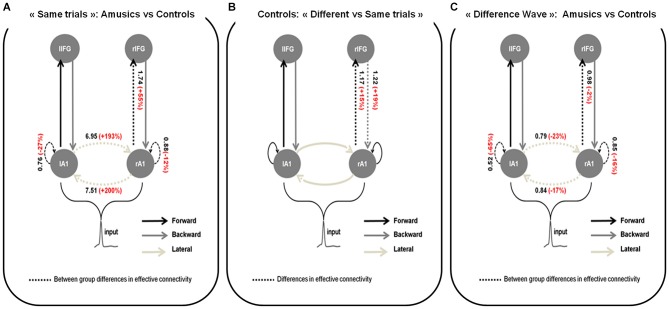
Wining models for (A) Amusics vs. Controls comparison for “Same” trials; (B) “Different” vs. “Same” trials in S2 for controls and; (C) Amusics vs. Controls for the “Difference Wave”. Dashed arrows indicate modulated connections (i.e., connections that differ between groups (A,C) or type of trial (B)) and solid arrows indicate fixed connections. Significant changes in effective coupling are specified (in black: amount of coupling change between groups (A,C) or type of trials (B); in red: corresponding relative coupling with amusics coupling expressed in % of control coupling (A,C) or with coupling for “Different” trials expressed in % of coupling for “Same” trials (B)).